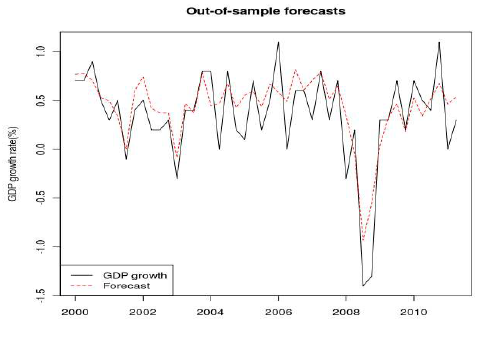
Fig 1. French GDP forecasting using the quantile loss function with τ